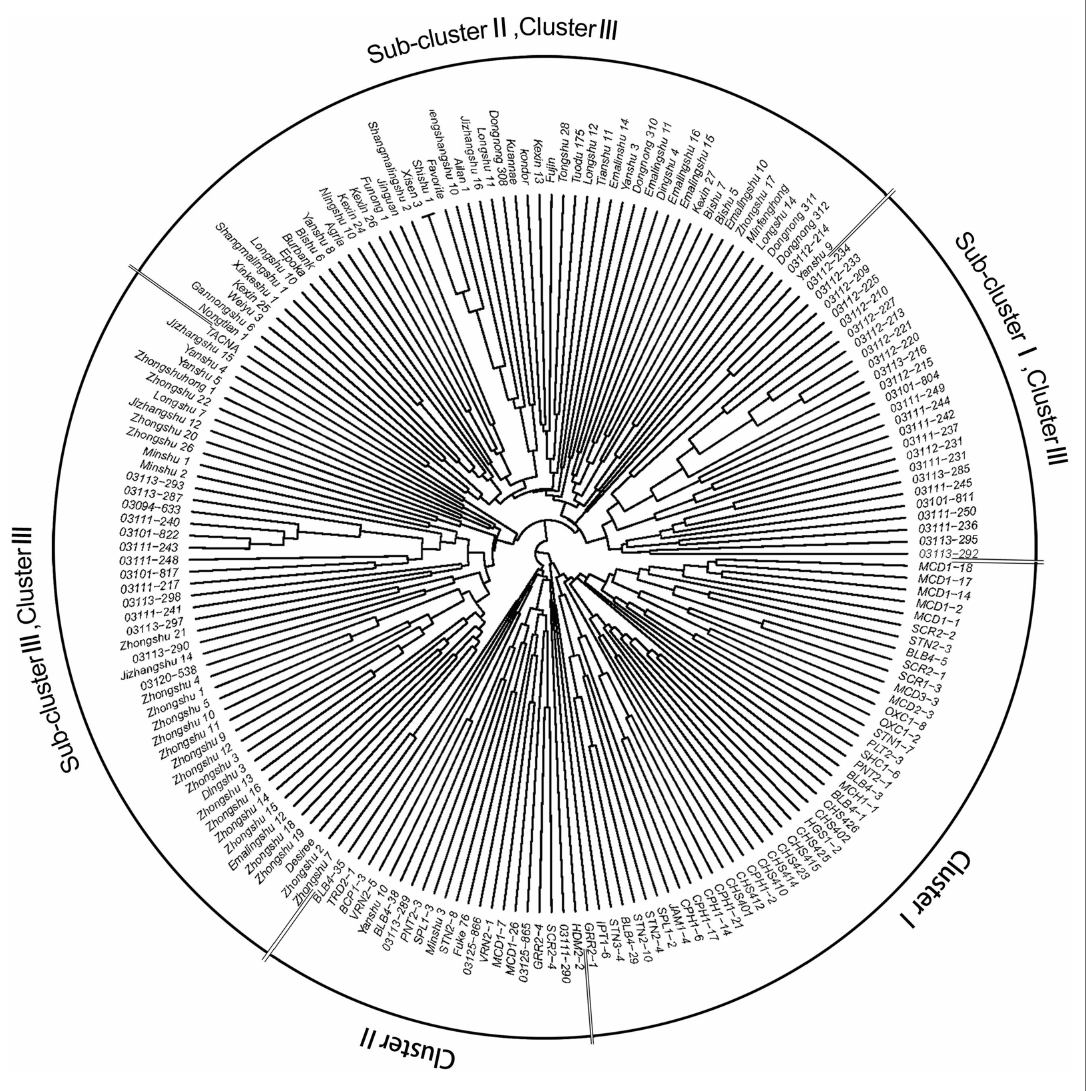
FIGURE 4 | Neighbor-joining tree based on a dissimilarity matrix of 189 potato genotypes examined with 30 SSR